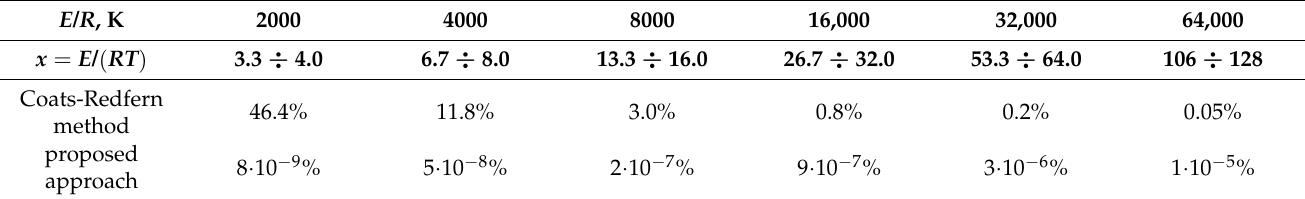
Table 2. Relative errors of Arrhenius integral approximations, %.